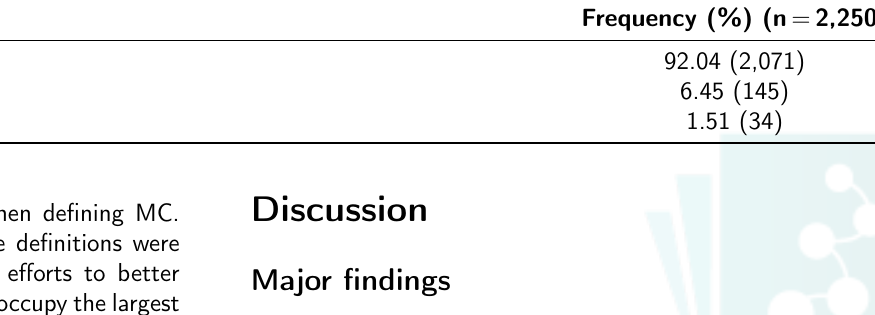
Table 2: Description of main condition definition agreement and